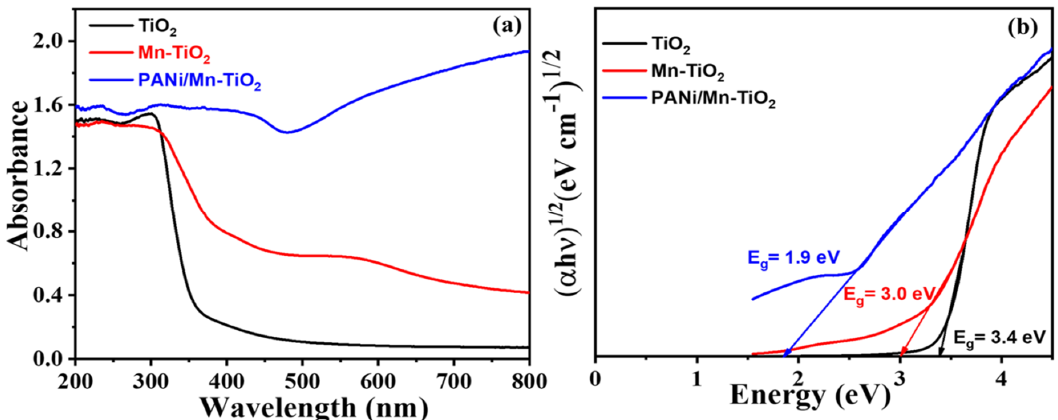
Figure 3. ( a ) UV-Visible spectra, and ( b ) Tauc plot of TiO 2 , Mn-TiO 2 and PANi/Mn-TiO 2 nanoparticles.